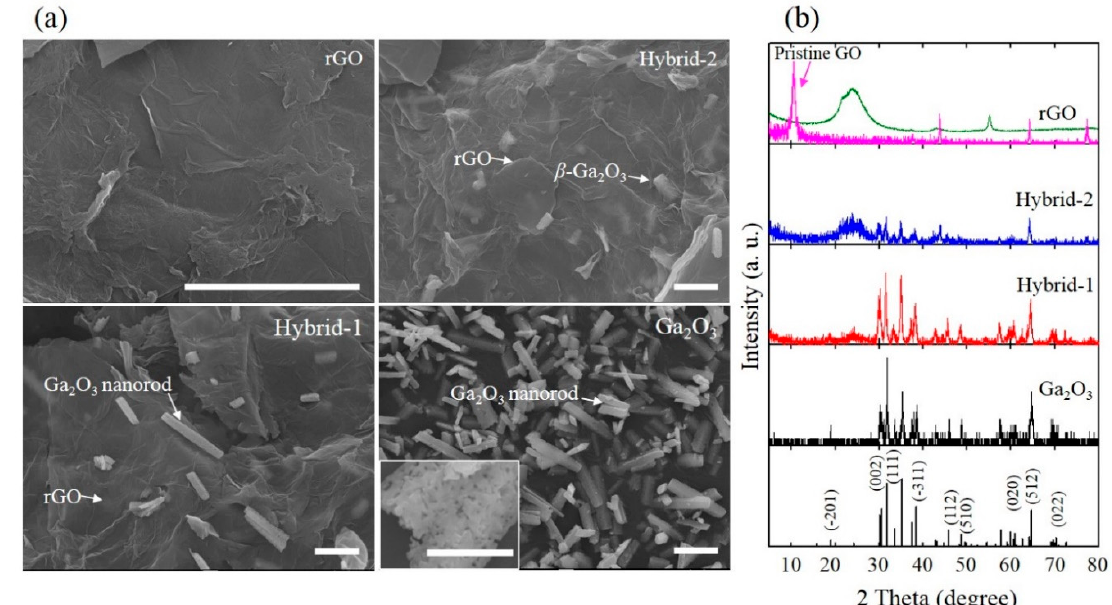
Figure 1. ( a ) FESEM images of rGO, Hybrid-2, Hybrid-1 and Ga 2 O 3 (the scale bar is 3 µ m); the scale bar of the inset is 1 µ m), and ( b ) XRD patterns of the pristine GO, rGO, Hybrid-2, Hybrid-1 and Ga 2 O 3 with the reference from Joint Committee on Powder Diffraction Standards (JCPDS) card no. 760573 (monoclinic Ga 2 O 3 phase).